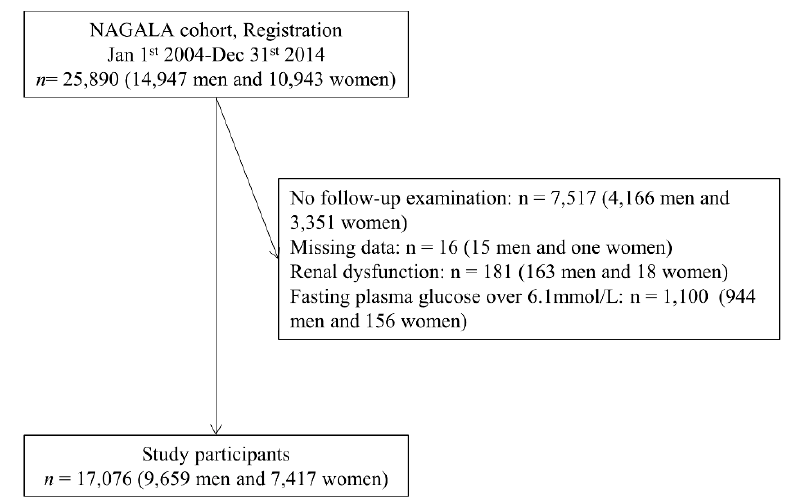
Figure 1. Inclusion and exclusion flow chart.